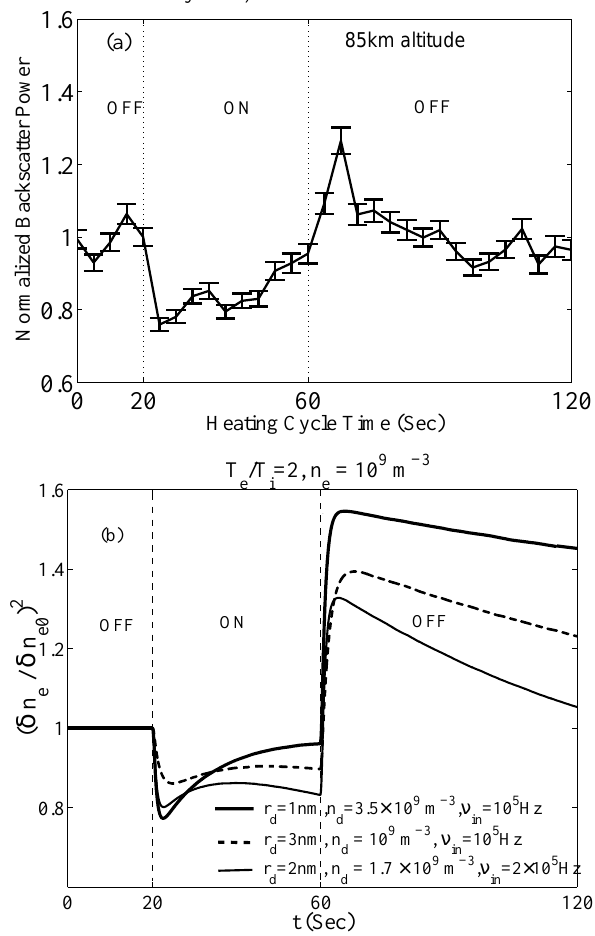
Fig. 8. A comparison of VHF radar superposed epoch data during radiowave heating and result from the computational model. Panel (a) shows the superposed epoch of PMSE VHF backscatter power, and panel (b) the computational model result.